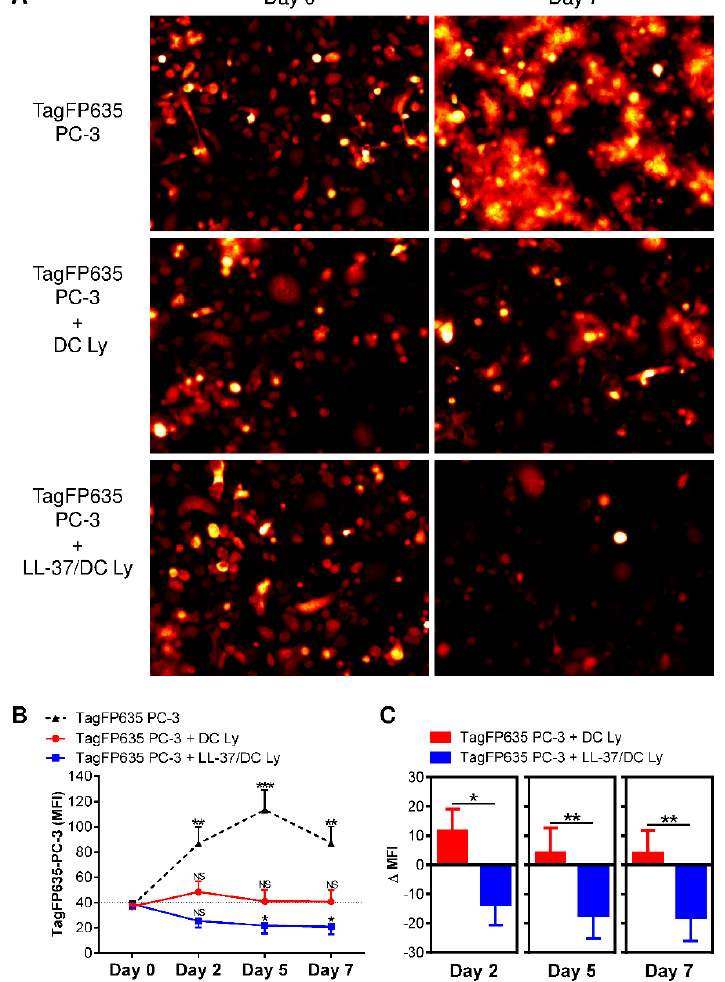
Figure 6. The application of LL-37 during DC production (differentiation, pulsation, and maturation) significantly enhanced the cytotoxic impact of DC-stimulated autologous lymphocytes on cultured tumor cells. ( A ) The 14-day autologous lymphocytes stimulated with DCs (DC Ly) or DCs produced in the presence (differentiation, pulsation, and maturation) of LL-37 (LL-37/DC Ly) were co-cultured with fluorescent TagFP635 PC-3 cells at the ratio of 5:1 (lymphocytes: PC-3 cells) for 7 days. TagFP635 fluorescence in the co-culture was acquired on days 0 (left images) and 7 (right images) of co-culturing. ( B ) The TagFP635 fluorescence in the co-culture was acquired on days 0, 2, 5, and 7 of co-culturing, and the mean fluorescence intensity (MFI) of the acquired images was calculated. The differences in the MFIs of individual days of co-culture for individual samples were statistically evaluated. The data represent mean + SEM or mean—SEM, and the significance of differences among the MFIs are indicated ( NS p > 0.05, * p < 0.05, ** p < 0.01, *** p < 0.001; n = eight donors; repeated measures one-way ANOVA with the Tukey’s post-test). ( C ) The differences between the MFIs before co-culturing (day 0) and at each individual day of co-culturing (days 2, 5, and 7) ( ∆ MFIs) were calculated for the DC Ly and LL-37/DC Ly samples and statistically evaluated. The data represent means + SEM or means—SEM, and the significance of differences among the ∆ MFIs are indicated (* p < 0.05, ** p < 0.01; n = eight donors; paired two-tailed Student’s t